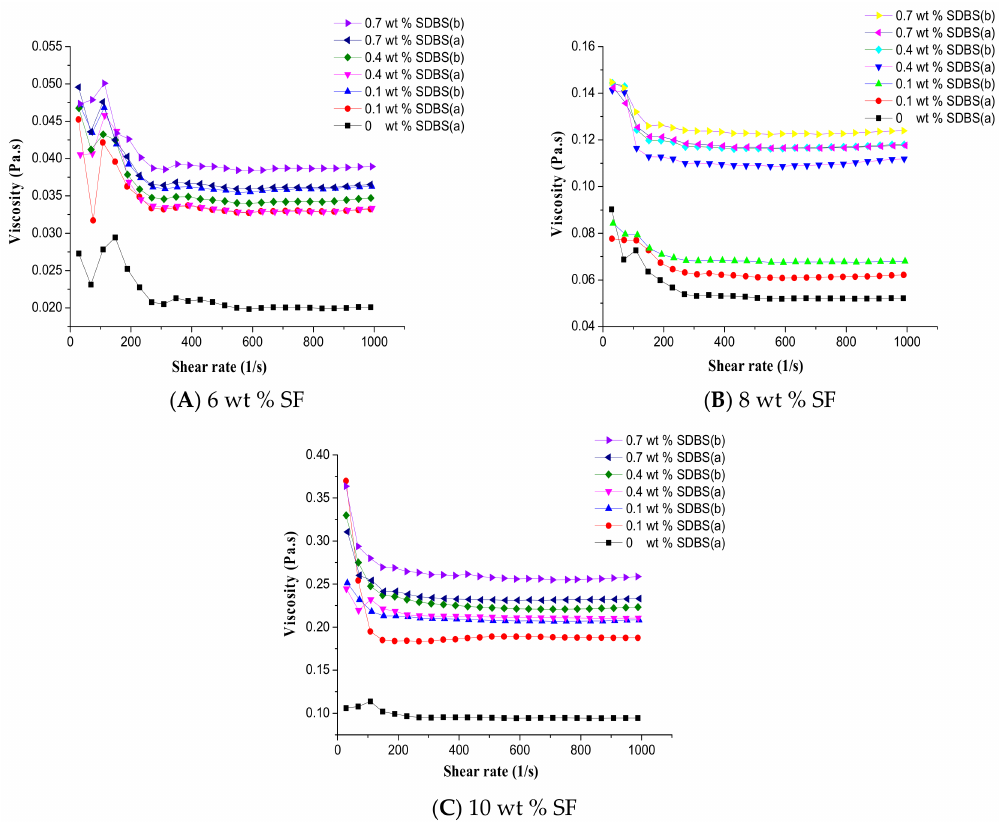
Figure 3. Rheological behavior between the shear viscosity and shear rate of the spinning solutions before spinning (a) and after spinning for 30 min (b) with SF concentrations of ( A ) 6 wt %; ( B ) 8 wt % and ( C ) 10 wt %,